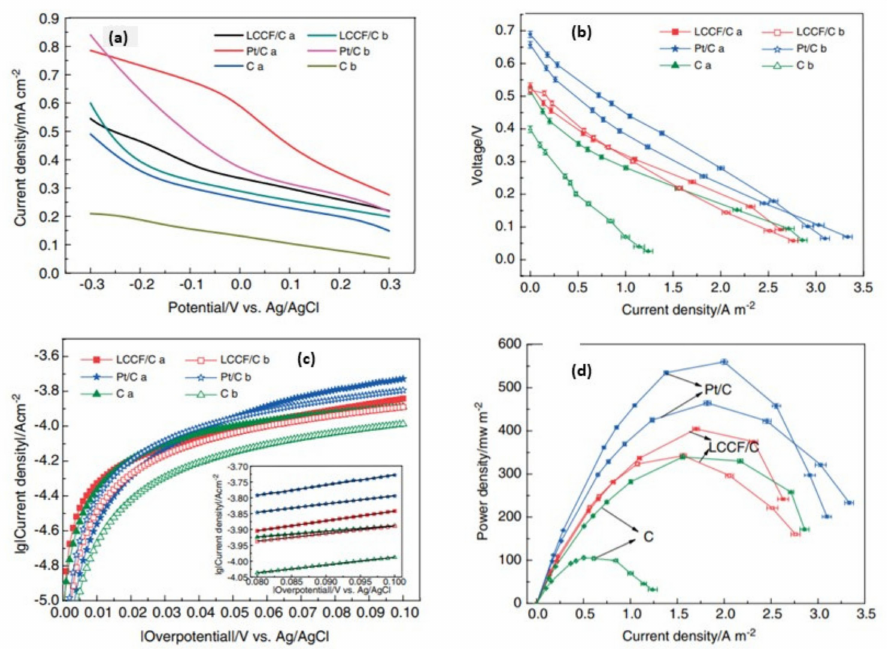
Figure 7. ( a ) Line sweep voltammograms; ( b ) MFC polarization; ( c ) Tafel plots; ( d ) curves with the three-air cathodes (50 mmol L − 1 PBS and T = 30 ◦ C) of LCCF/C, Pt/C and C cathodes. (Reprinted with permission from [53]. Copyright 2012, Wiley Online